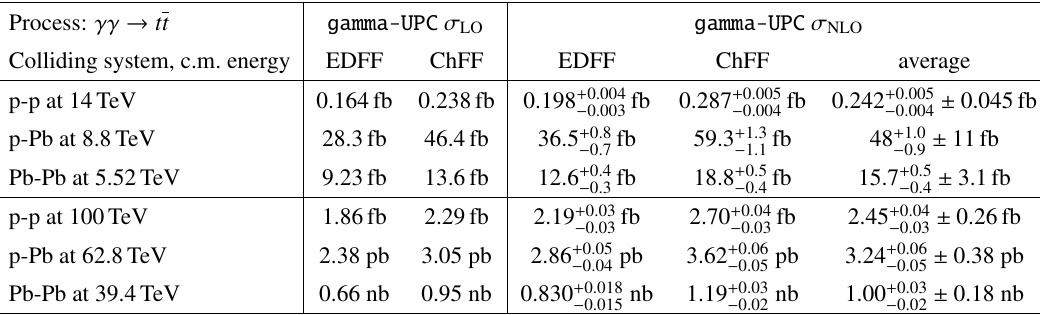
Table 10 . Total LO and NLO QCD cross sections for (cid:13)(cid:13) ! tt in UPCs at the LHC, computed with EDFF and ChFF (cid:13) fluxes, and their average for the NLO case. The quoted asymmetric NLO uncertainty is derived from the renormalization scale variation.